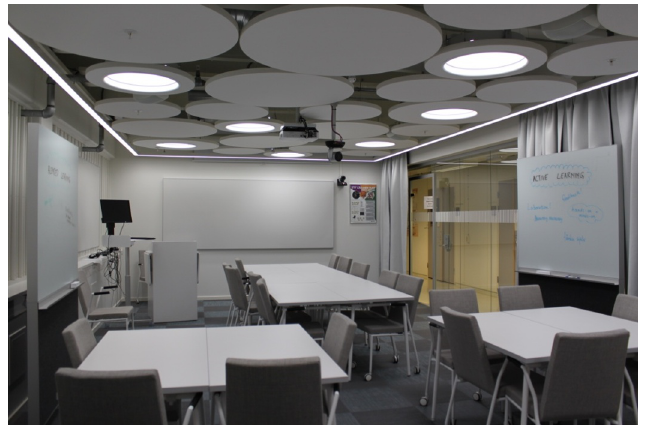
Fig. 2 - Picture of the interactive teaching room developed at Chalmers University of Technology (©Anna